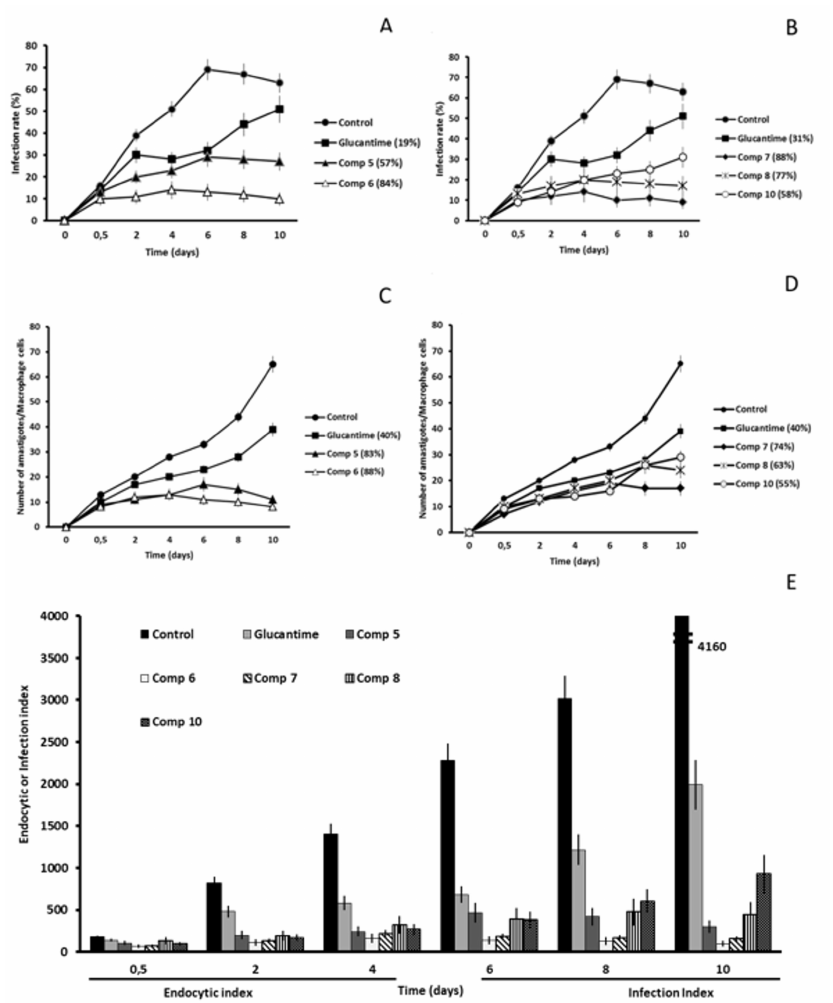
Figure 3. Leishmania donovani infectivity assay. ( A , B ) Infection rate percentage and ( C , D ) amastigote count per macrophage cell. In brackets: percentage of decrease in infection rate/number of amastigotes per macrophage cell in comparison to the control measured on the last day of the experiment (peak of infection). ( E ) Effects of the compounds on the endocytic and infection indexes. Each drug at IC 25 concentration was tested in triplicate. Values are the means of four separate determinations ± standard